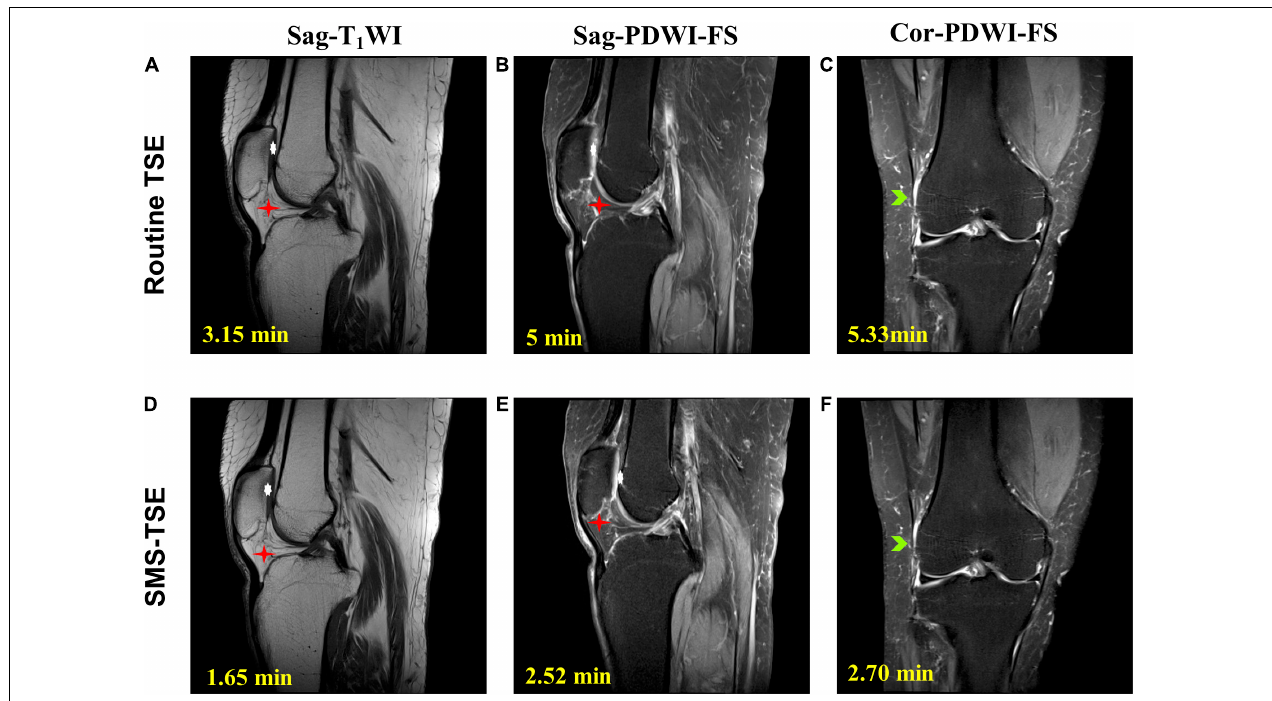
FIGURE 3 | Comparison of the high-resolution turbo spin-echo (TSE) sequence and simultaneous multi-slice-TSE sequence in the knee joint imaging. On the magnetic resonance images, the degeneration of the knee joint is clearly depicted. All the images scored 5 in the image quality evaluation. For routine TSE, the SNR for Sag-T1WI (A) , Sag-PDWI-FS (B) a d Cor-PDWI-FS (C) were 30.75, 72.86, and 78.67; and the CNR for each was 88.89, 44.39, and 43.18. For the SMS-TSE, the SNR for Sag-T1WI (D) , Sag-PDWI-FS (E) a d Cor-PDWI-FS (F) were 29.22, 73.47, and 68.61; and the CNR for each was 77.11, 45.68, and 41.35. TABLE 2 | Comparison of the signal-to-noise ratio (SNR), contrast-to-noise ratio (CNR), and SNR/min between the routine turbo spin-echo (TSE) and simultaneous multi-slice (SMS)-TSE sequences. Quantitative parameters SNR CNR SMS-TSE Routine TSE SMS-TSE Routine